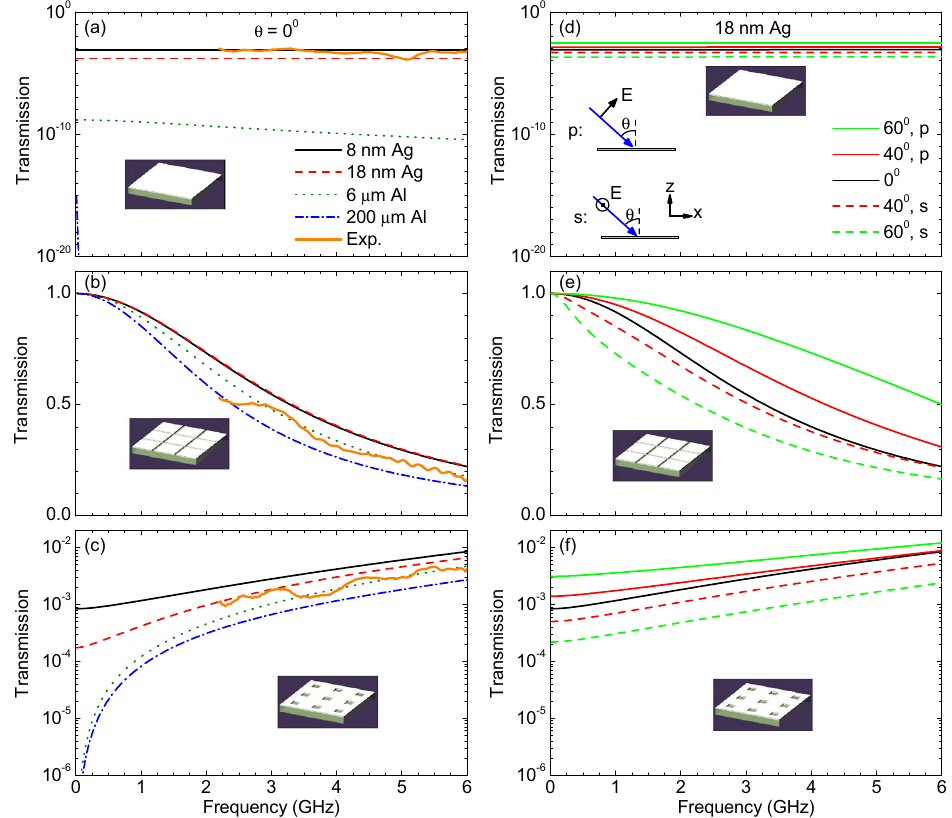
Figure 3. Making low-e materials transparent in GHz band by metasurfaces. ( a – c ) Calculated transmission spectra for the structures in Fig. 1(a–c) at normal incidence, respectively. The substrate has a thickness t 2 = 1 mm and dielectric constant ε = 4. In ( b , c ), the periodicity a = 2 cm and the filling ratio of air is 0.1 in the coatings. The orange solid lines are the measured spectra for 1 mm-thick glass samples coated by 3-nm-thick TiO 2 , 1-nm-thick Au, 12-nm-thick Ag, 1-nm-thick Au and 100-nm-thick TiO 2 . ( d – f ) Calculated transmission spectra for the structures in Fig. 1(a–c) at oblique incidence, respectively. The substrate is coated by a 18 nm- thick Ag film and other parameters are the same as in ( a – c